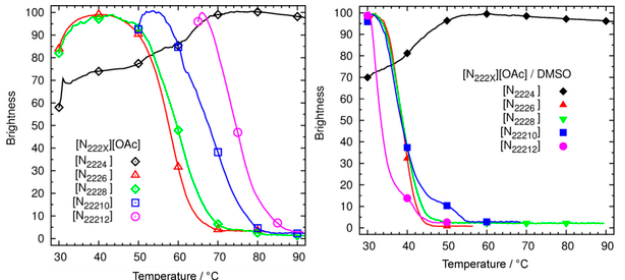
Figure 5 . Comparison of the temperature of dissolution of 10 wt% microcrystalline cellulose in pure N 222R AcO (top) and in mixtures of N 222R AcO/DMSO (80/20 wt%, bottom); reprinted (adapted) with permission from [73], Copyright (2017) Wiley-VCH Verlag.